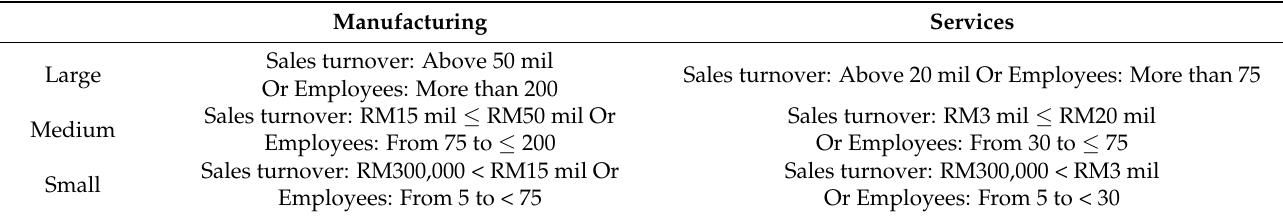
Table 1. Taxonomy for classification of companies.